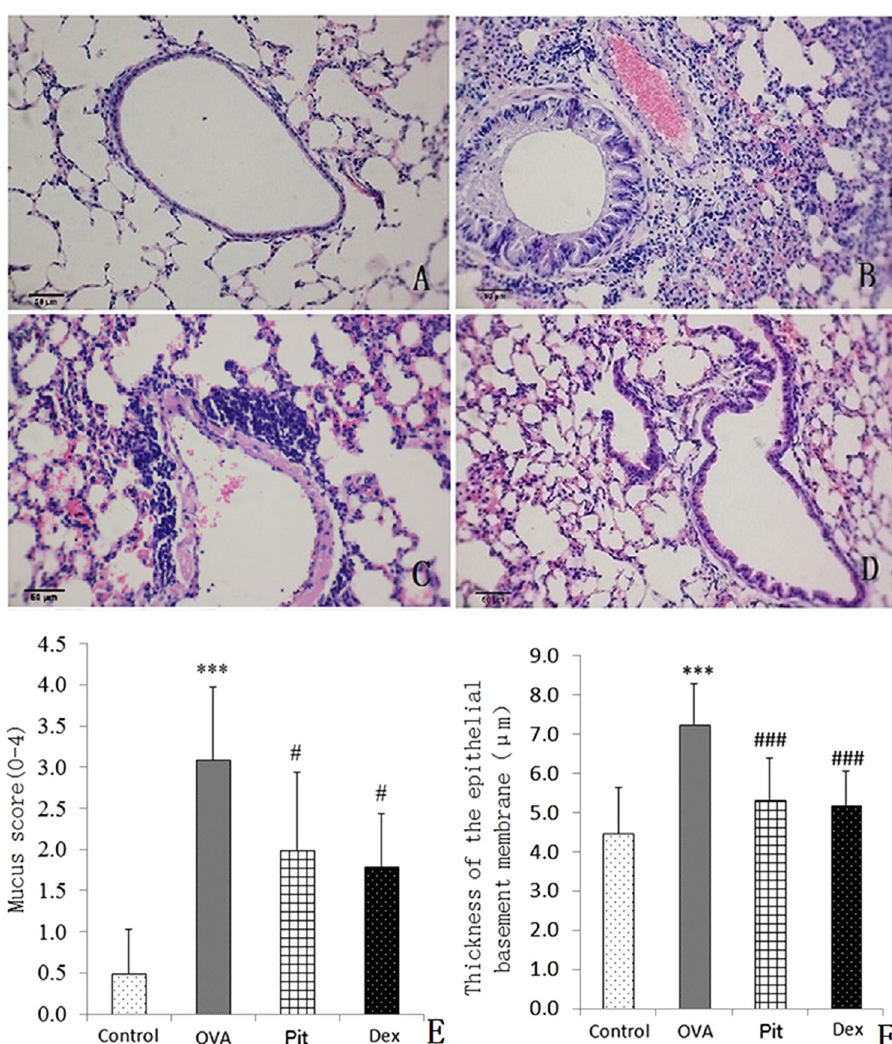
Figure 4. Effects of pitavastatin on OVA-induced lung histological changes, as determined by H&E staining (100 × ). ( A ) Control mice treated with aerosolized PBS. ( B ) Mice challenged with OVA and treated with PBS showing a peribronchial inflammatory infiltrate consisting mainly of eosinophils and lymphocytes. The blood vessels are surrounded by cuffs of inflammatory cells and contain marginating eosinophils, which migrated into their walls. ( C ) Mice challenged with OVA and treated with inhaled pitavastatin. ( D ) Mice challenged with OVA and treated with i.p. injections of dexamethasone. These panels depict the histological features representative of each condition in seven or eight mice per group. ( E ) Quantitative analysis of the degree of inflammatory cell infiltration in the lung sections, which was based on the methods developed by Myou and Lee 48, 49 . ( F ) Changes in the thickness of the reticular basement membrane of each group of mice with asthma. *** P < 0.001 compared with the control group; ### P < 0.001 compared with the OVA